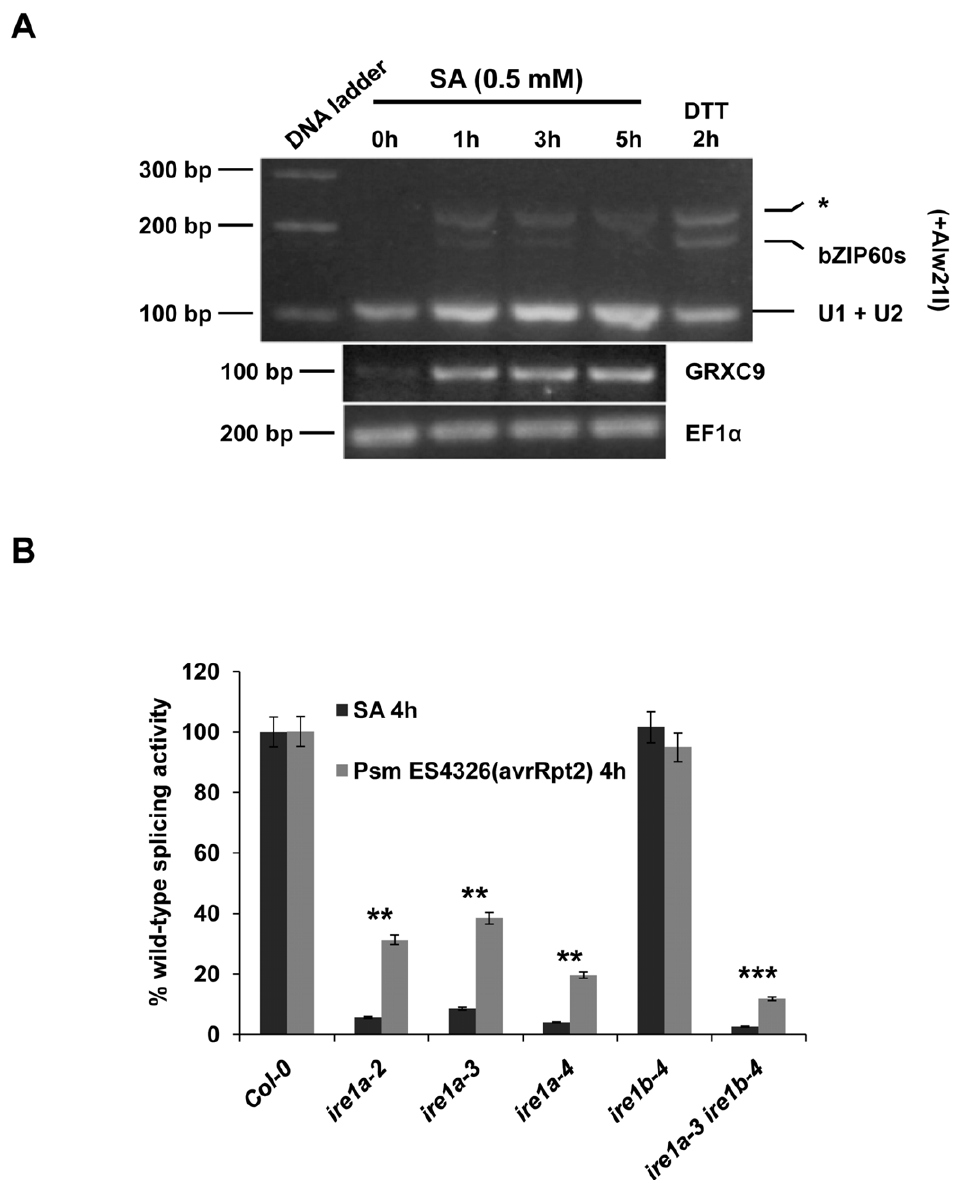
Figure 6. Salicylic acid stimulates bZIP60 processing. A, RT-PCR products derived from bZIP60 mRNA were digested with Alw21I and resolved by gel electrophoresis in agarose (3.5% p/v). RNA samples were obtained from seedlings (6-days-old) of wild-type plants treated with salicylic acid (SA) for the indicated time. As a positive control we used a RNA sample obtained from seedlings treated with DTT (5 mM) for 2 hours. GRXC9 gene expression served as control for the action of SA at transcriptional level [29,57]. Elongation factor 1 alpha (EF1 a ) gene expression served as a control. B, Pathogen infection and SA induce bZIP60 splicing in IRE1a-dependent manner. cDNA was made from the leaf tissue of 3-week-old plants of the indicated genotypes infected with Psm ES4326(avrRpt2) or sprayed with SA for 4 hours. Ratios of fold induction of spliced and unspliced bZIP60 in the listed genotypes are plotted, while ratio of Col-0 was set as 100%. Statistical analysis was performed using Student’s t -test, **, p , 0.01, ***, p # 0.001. All the experiments were performed at least three times with similar